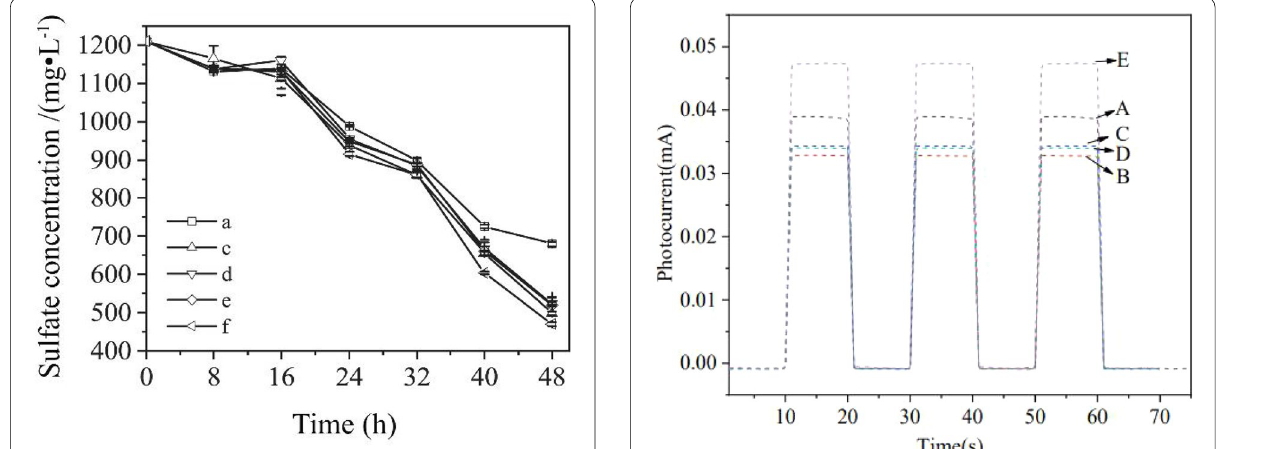
Fig. 8 Effect of EPS components on instantaneous photo-current intensity. A EPS with proteinase treatment; B EPS with